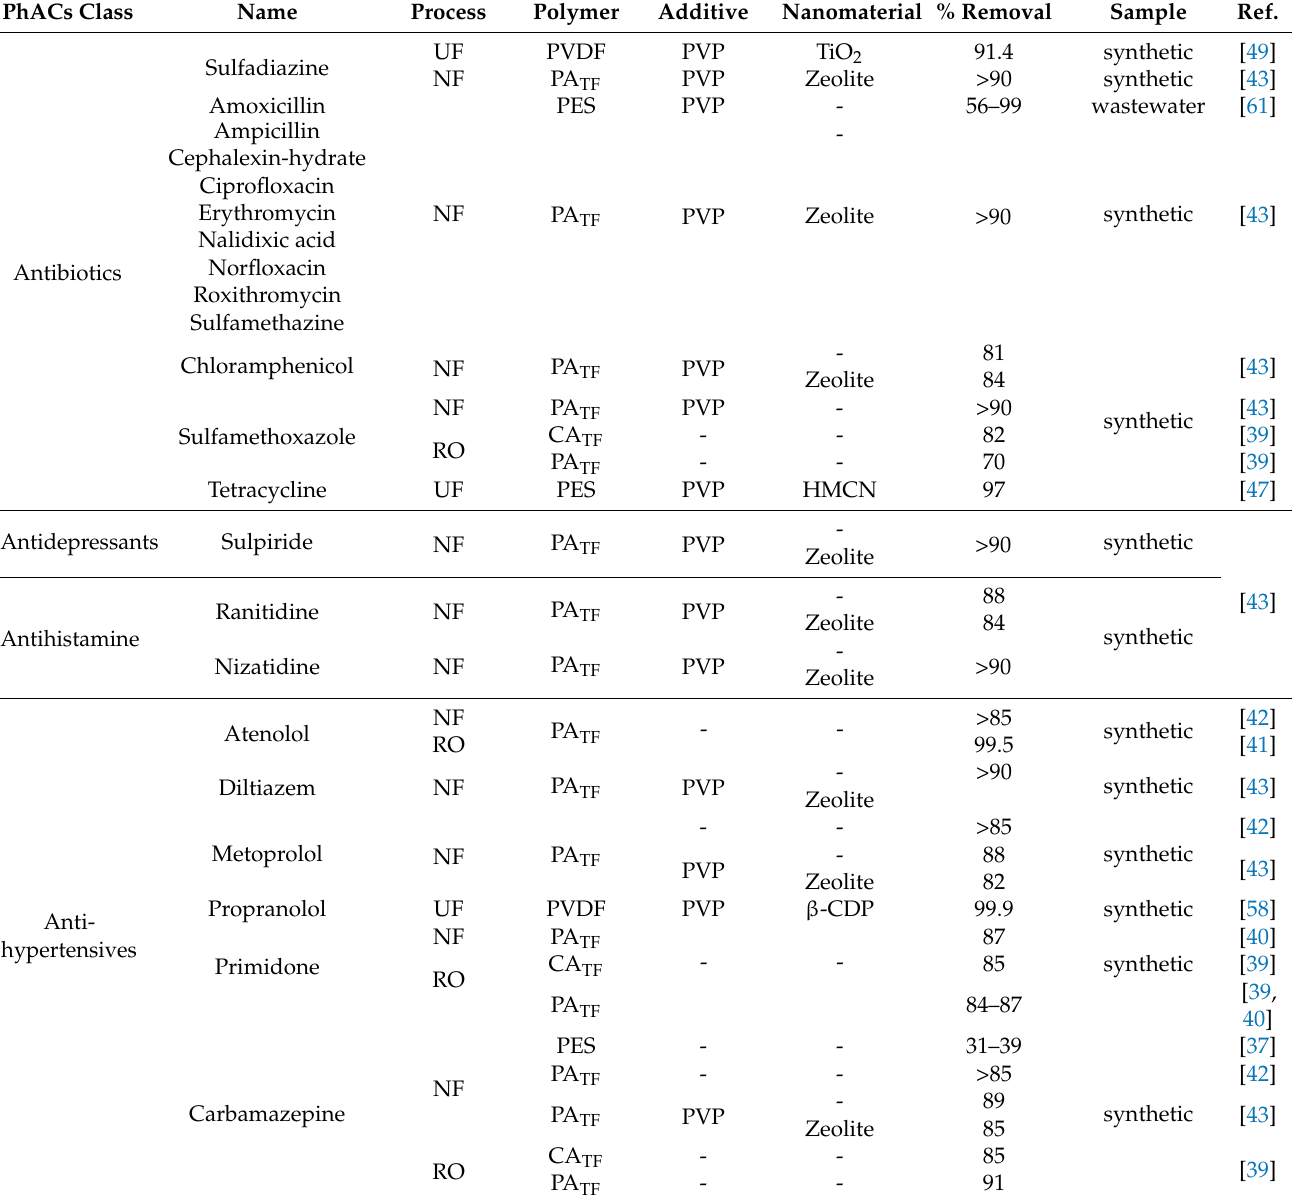
Table 1. Application of polymeric membranes in the purification of water contaminated with